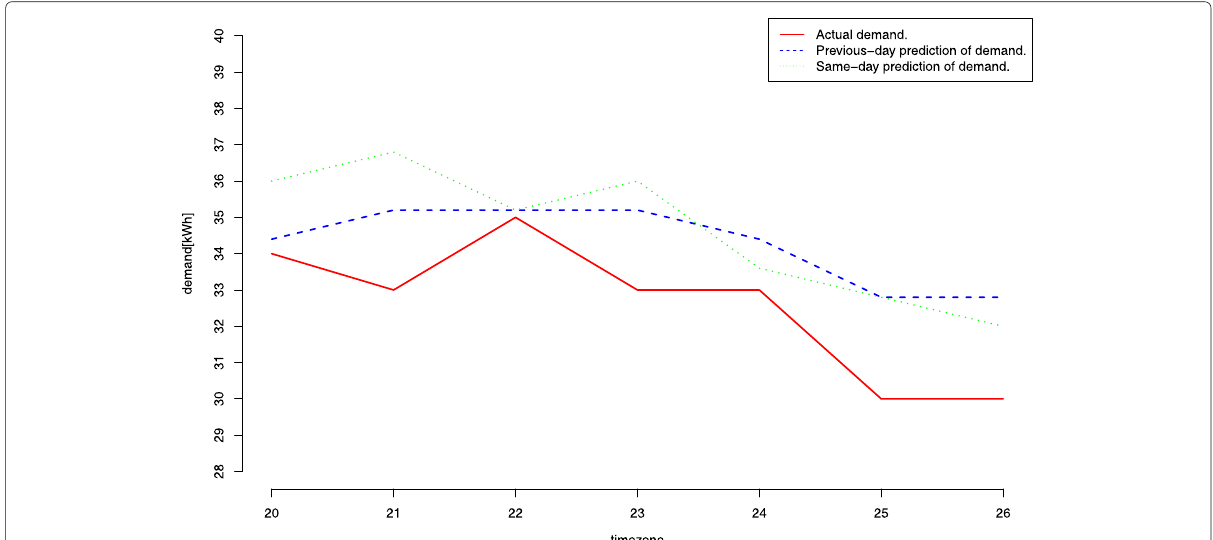
Fig. 5 Actual vs. predicted data ( d = 10). This figure is a line chart of the actual demand, the previous-day prediction of demand, and the same-day prediction of demand when d =